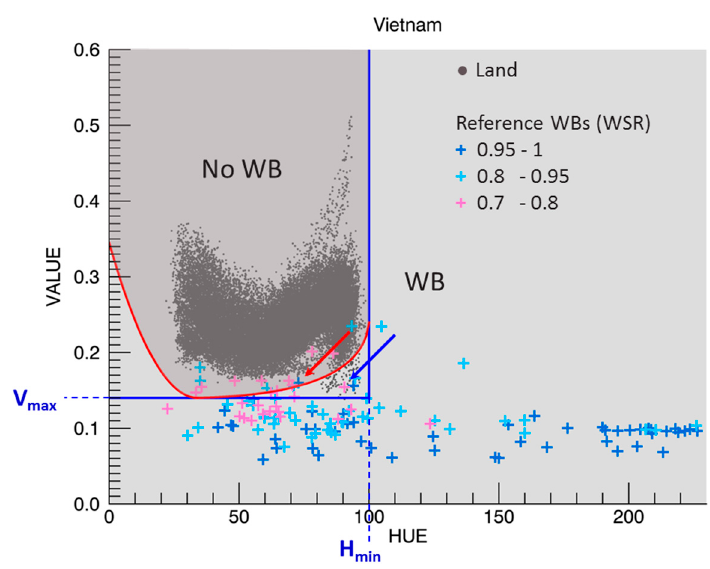
Figure 6. 2D scatter plots of the Vietnam test area showing the final threshold levels. Land pixels are indicated by the dark grey dots, reference WBs (obtained from Landsat 8) are indicated by the colored plus symbols for different ranges of water surface ratios. The fixed threshold levels are indicated by the blue lines (V max and H min ). The refined threshold levels, indicated by the red parabolic lines, allow the detection of WBs outside the fixed threshold levels as indicated by the blue arrow. The red arrow locates the intermixed water and land pixels.